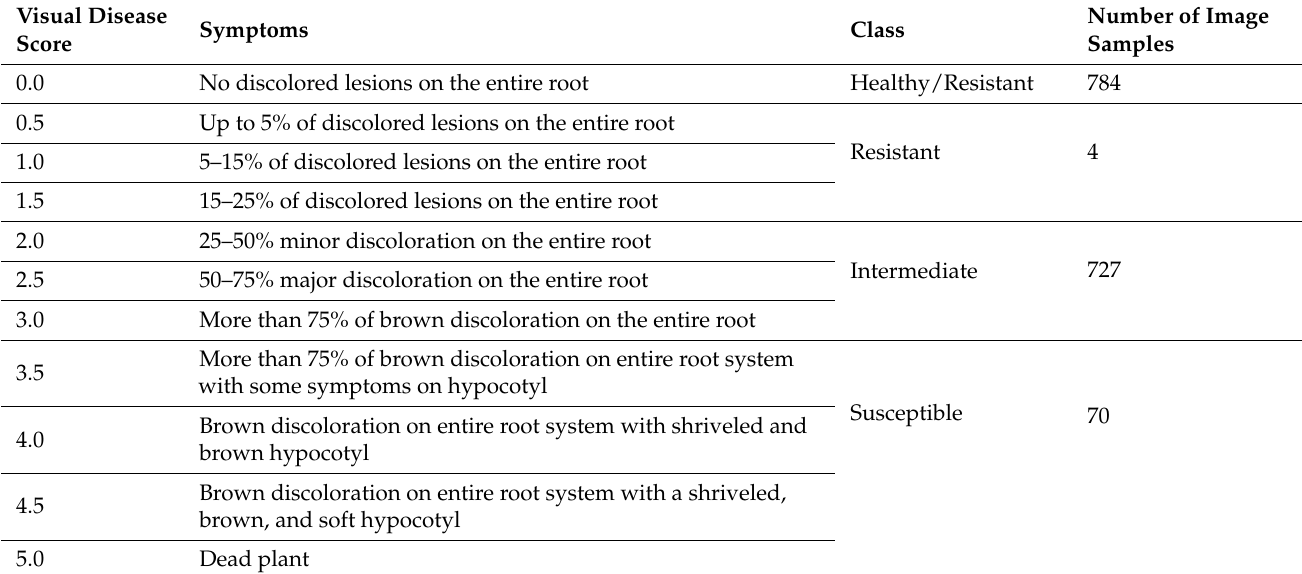
Table 1. Aphanomyces root rot visual disease scoring